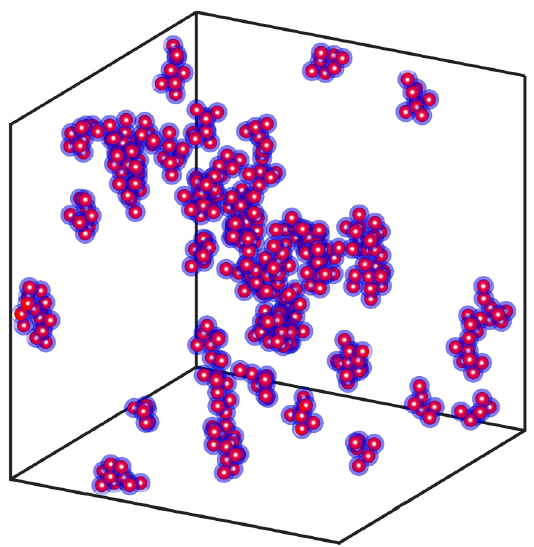
Figure 7. System of nanoparticle aggregates consisting of 5 to 10 nanoparticles with fractal dimension ranging from 2.1 to 2.4, with a volume fraction of 0.01 and a nanolayer thickness of 45% of the particle radius.